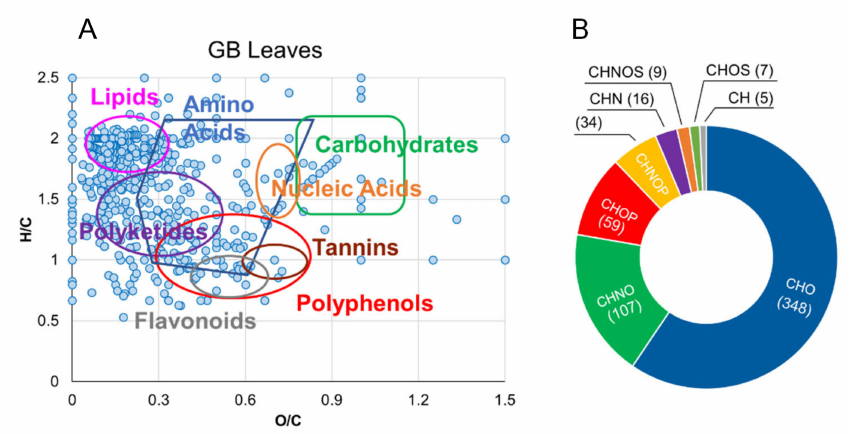
Figure 4. Van Krevelen diagram obtained from the molecular formulas determined by ESI FT-ICR analyses of hydroalcoholic and organic Big Lifeberry leaves extracts (panel A ); donut chart describing the elemental composition concerning the same extracts (panel B